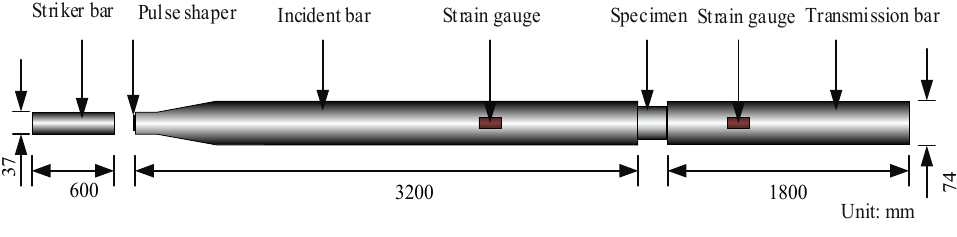
Figure 4. Schematic diagram of SHPB test.